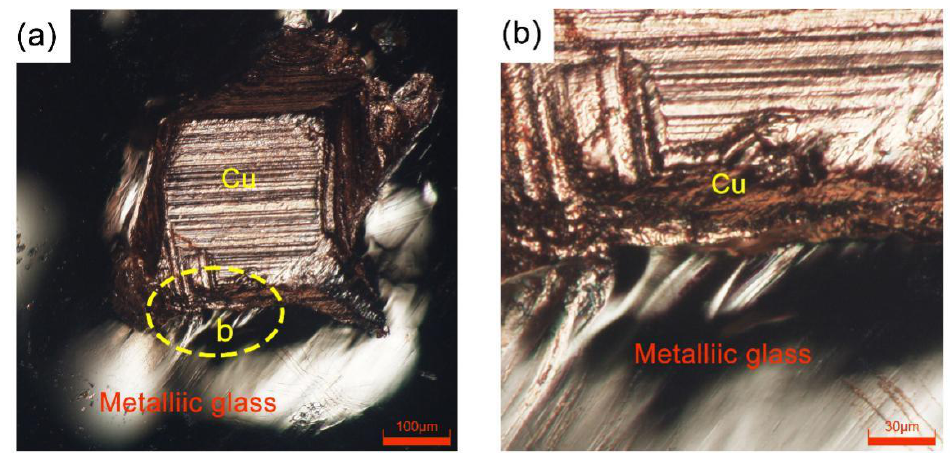
Figure 5. The joint surface morphology of the Cu/Ni-based (MG) composite sample at a bonding time of 140 ms ( a ), and a larger view of the boundary ( b ).